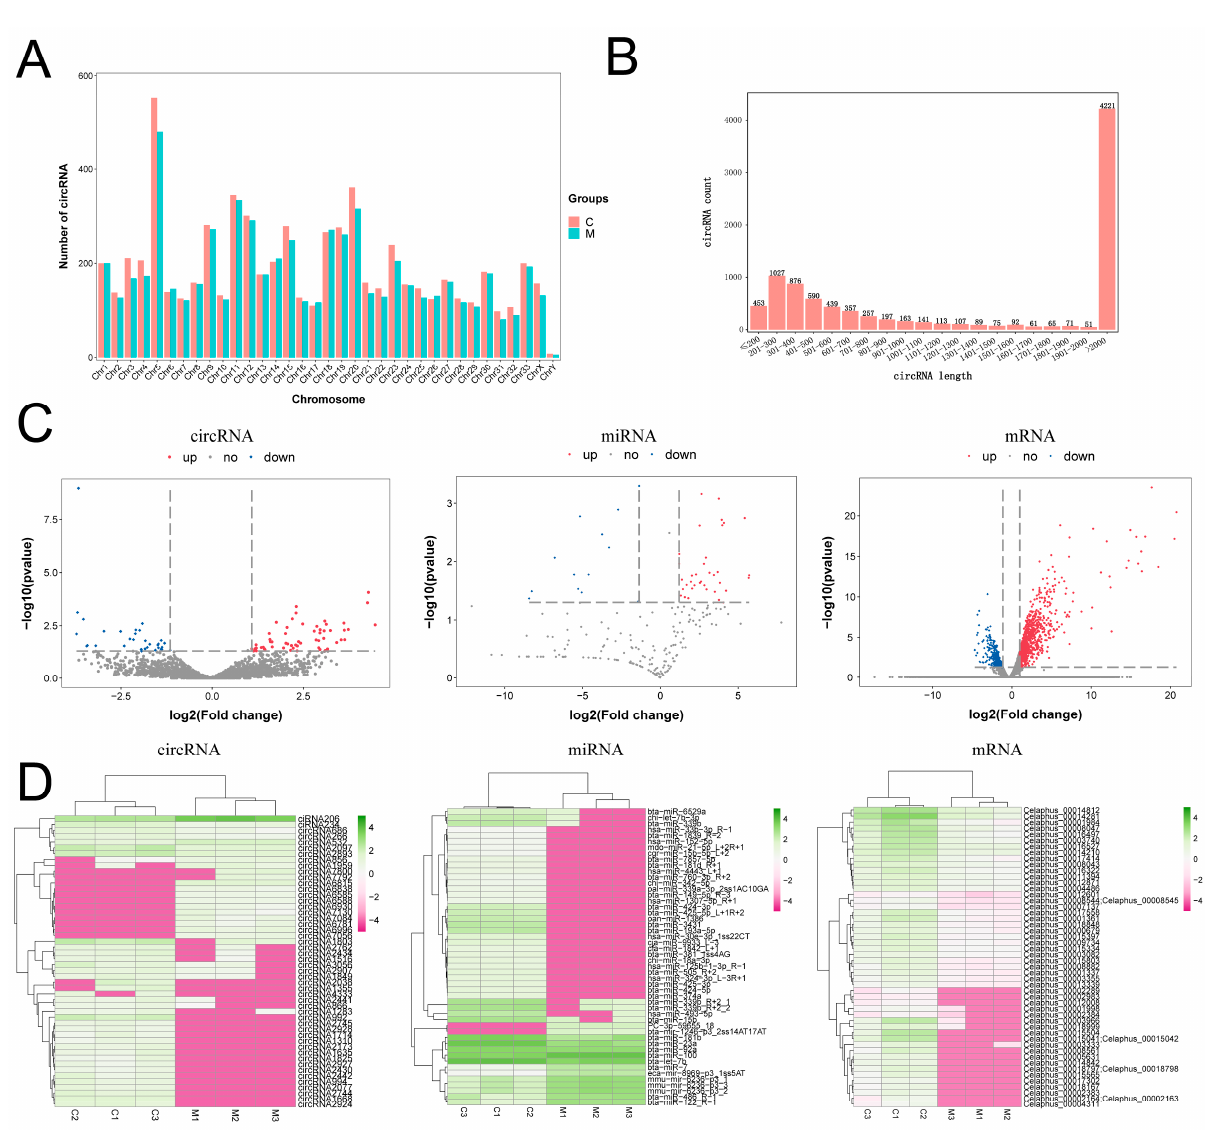
Figure 1. Analysis of the differentially expressed circRNA, miRNA, and mRNA in tip tissue of antlers. ( A ) circRNA distribution on chromosomes. ( B ) The length distribution of circRNA. ( C ) Volcano diagrams of differential circRNA, miRNA, and mRNA. DEGs were selected with an absolute value of the thresholds of fold change ≥ 1 and p <0.05, the red dots represent upregulated differential genes, the blue dots represent downregulated differential genes, and the black dots represent genes with no significant difference. ( D ) Clustering heatmap of the top 50 differentially expressed circRNA, miRNA, and mRNA; the pink represents downregulated and the green represents upregulated.